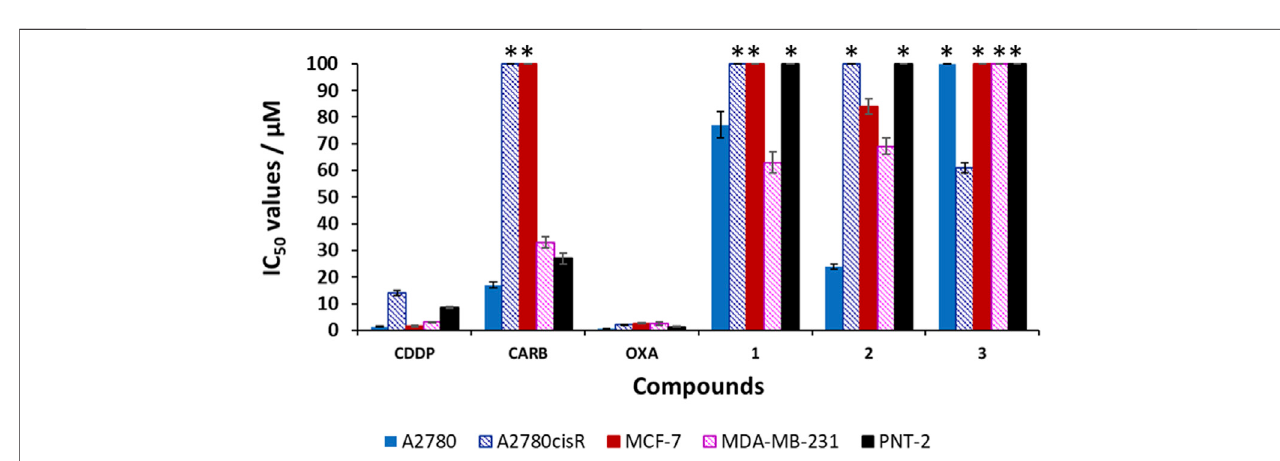
FIGURE 6 | Cytotoxicity values (IC 50 / μ M ± SD) for cisplatin ( CDDP ), carboplatin ( CARB ), oxaliplatin ( OXA ) and compounds 1 – 3 against human cell lines: ovarian carcinomas (A2780, A2780cisR), breast adenocarcinomas (MCF-7, MDA-MB-231) and non-malignant prostate (PNT-2). * indicates that the IC 50 value is greater than the tested threshold concentration of 100